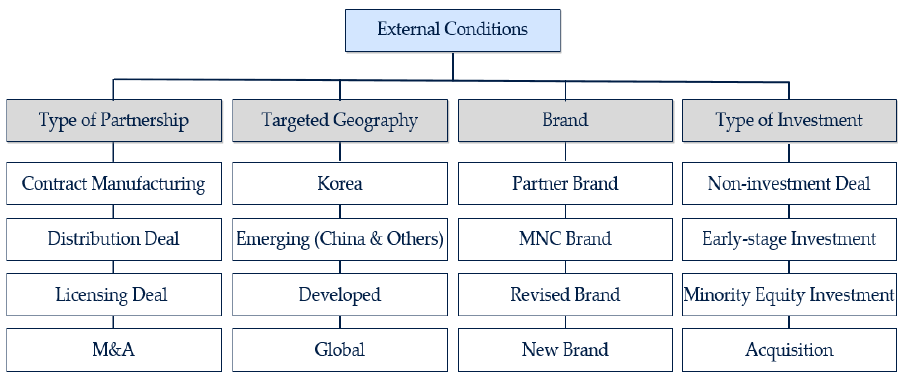
Figure 2. Research framework: external conditions for partnership .